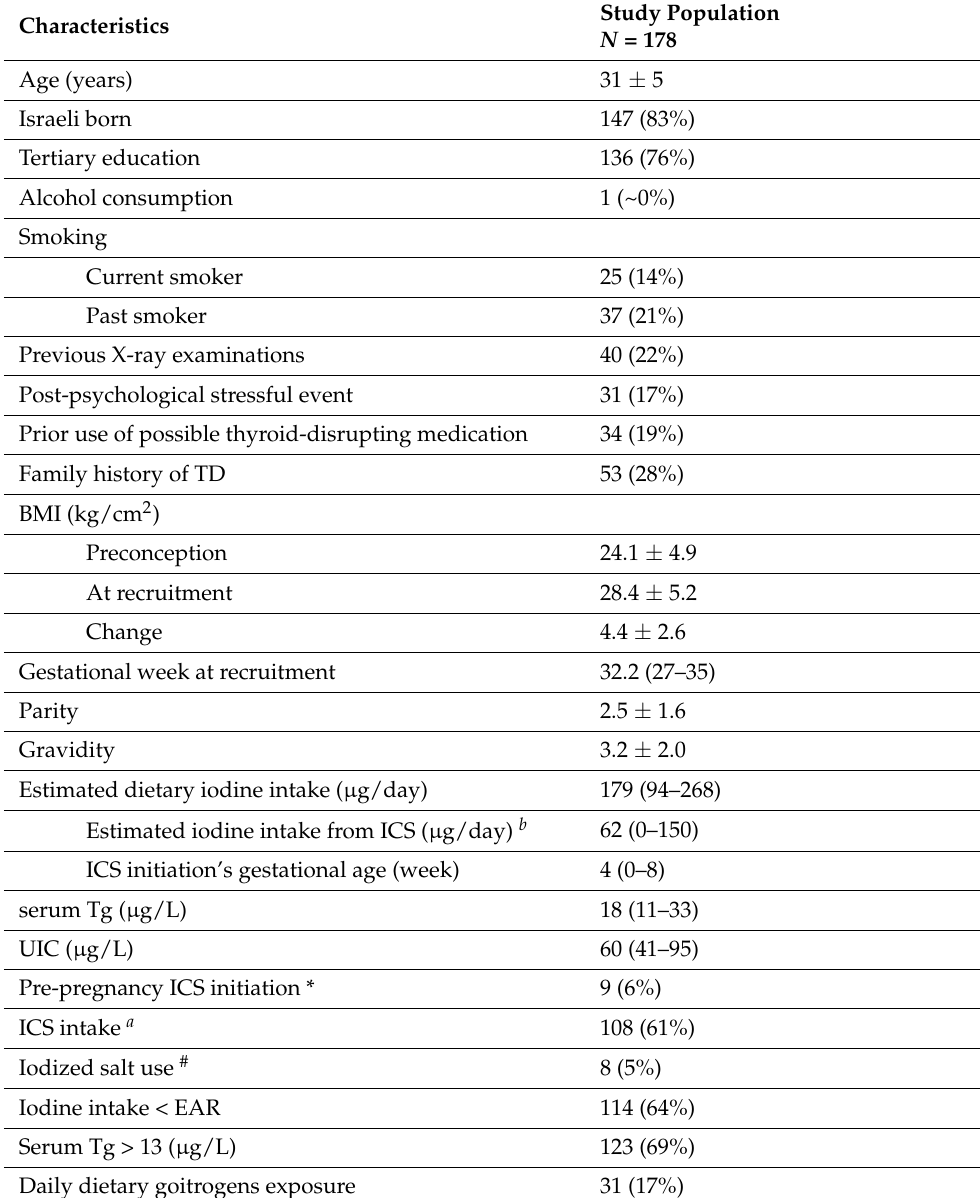
Table 1. Descriptive characteristics d of the study